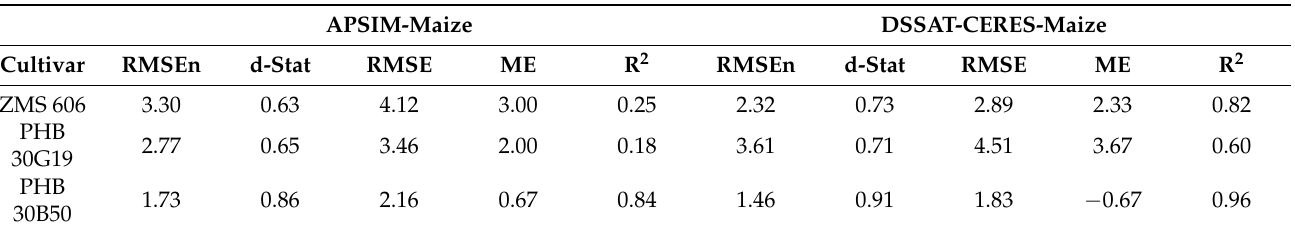
Table 7. The APSIM-Maize and DSSAT-CERES-Maize model calibration statistics for the days after planting (DAP) to maturity for maize cultivars under rainfed conditions.